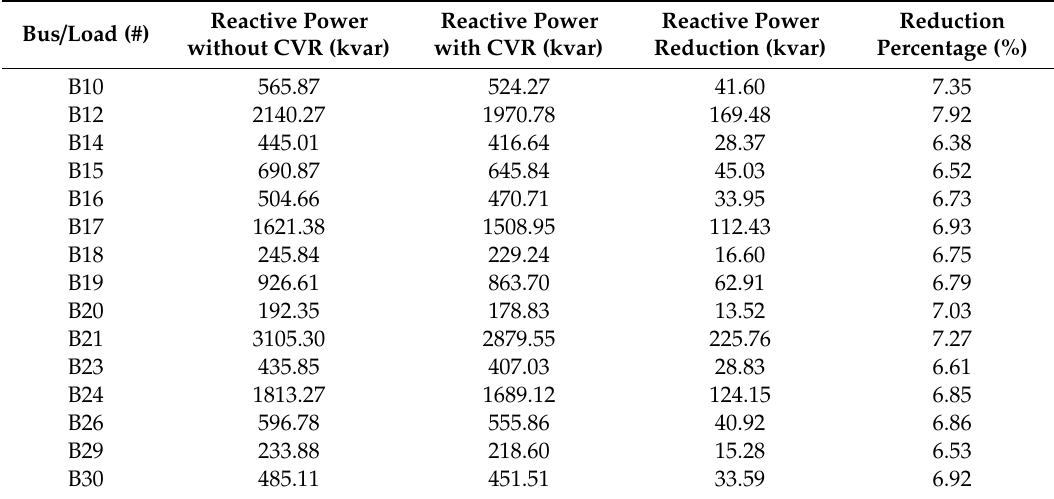
Table 6. Case V: Reactive power with / without CVR in the presence of